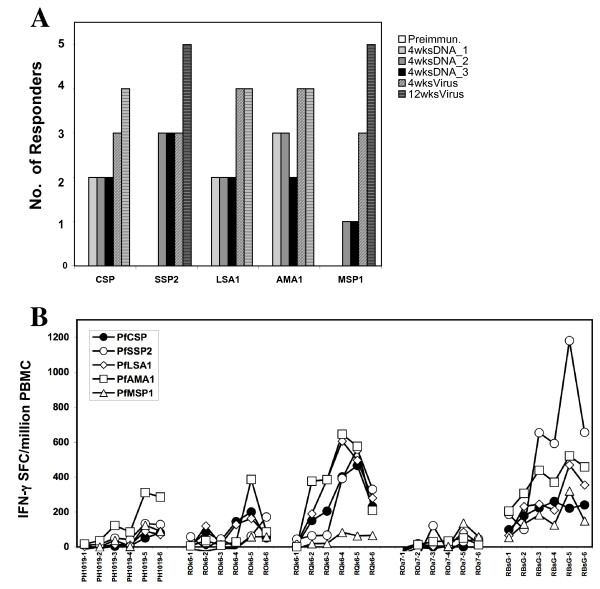
A. Frequency of IFN-γ ELIspot responders to all CSLAM antigen components in CSLAM/PBS immunized monkeys. Monkeys were immunized with CSLAM/PBS, and PBMC collected at time points as defined in the legend to Figure 2 were assayed against recombinant PfCSP, PfLSA1, PfAMA1 or PfMSP1 protein and PfSSP2/TRAP peptide pools by IFN-γ ELIspot. B. Magnitude of IFN-γ ELIspot responses to all CSLAM antigen components in CSLAM/PBS immunized monkeys. Monkeys were immunized with CSLAM/PBS and PBMC collected at defined time points were assayed against recombinant PfCSP, PfLSA1, PfAMA1 or PfMSP1 protein and PfSSP2/TRAP peptide pools by IFN-γ ELIspot. Time point number 1, 2, 3, 4, 5, and 6 represent time points pre-immunization, 4 wks post 1st DNA immunization, 4 wks post 2nd DNA immunization, 4 wks post 3rd DNA immunization, 4 wks post ALVAC-Pf7 boost, and 12 wks post ALVAC-Pf7 boost, for monkeys PH1019, ROk6, RQk6, ROa7 and RBsG, respectively.